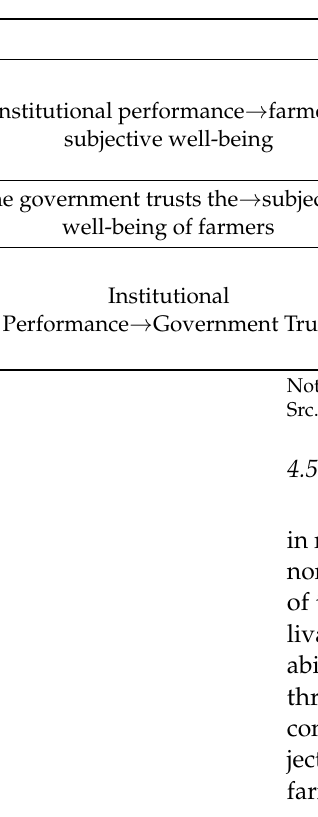
Table 5. Model Fitting Path Coefficients and